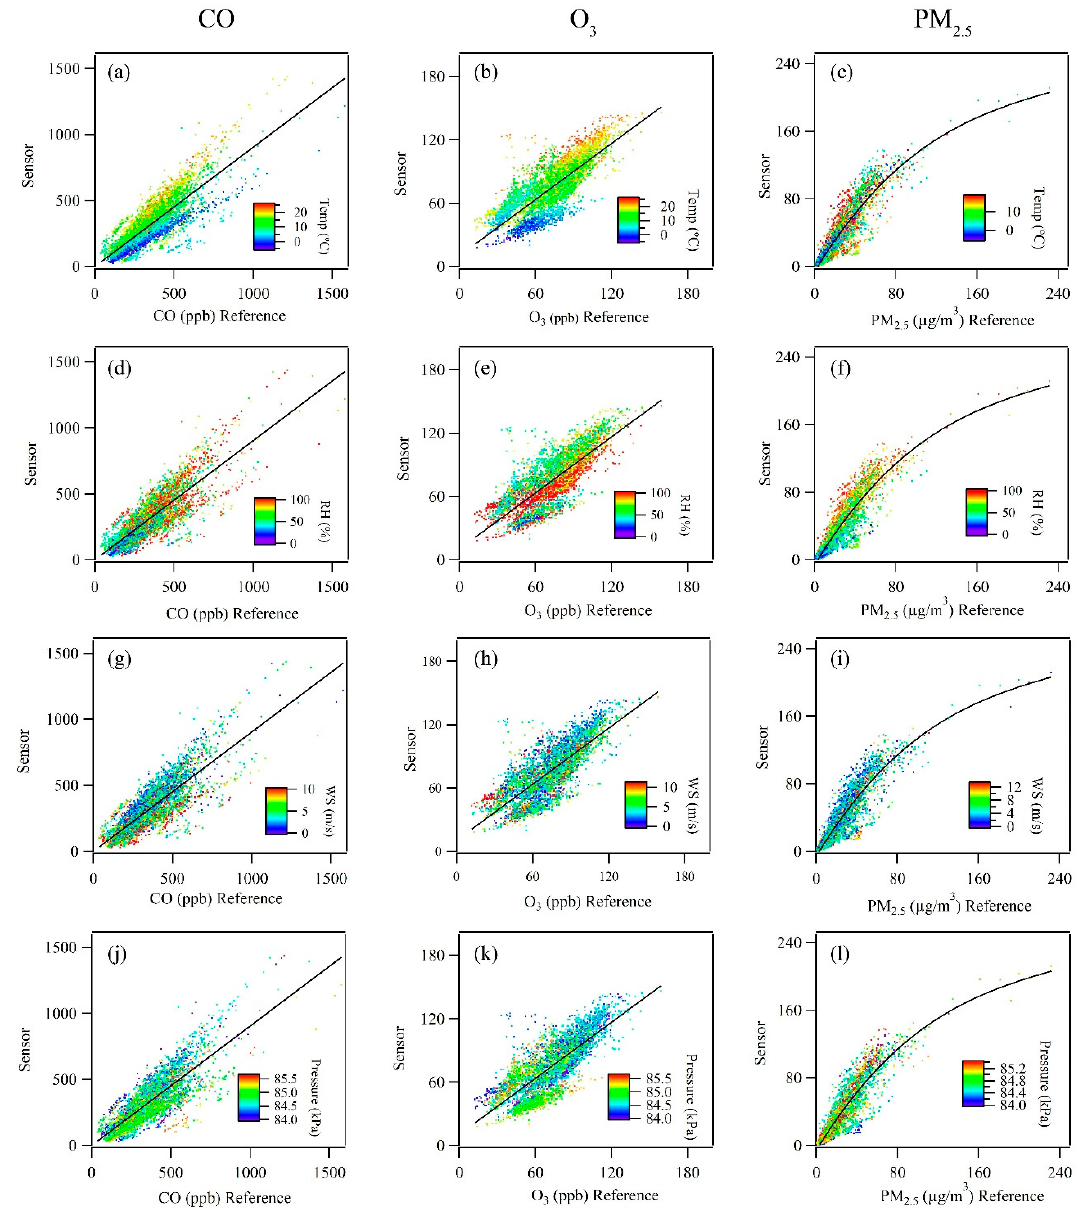
Figure 6. Scatter plots of sensor data and reference data, color-coded with meteorological factors: ( a – c ) temperature, ( d – f ) relative humidity, ( g – i ) wind speed, and ( j – l ) pressure.